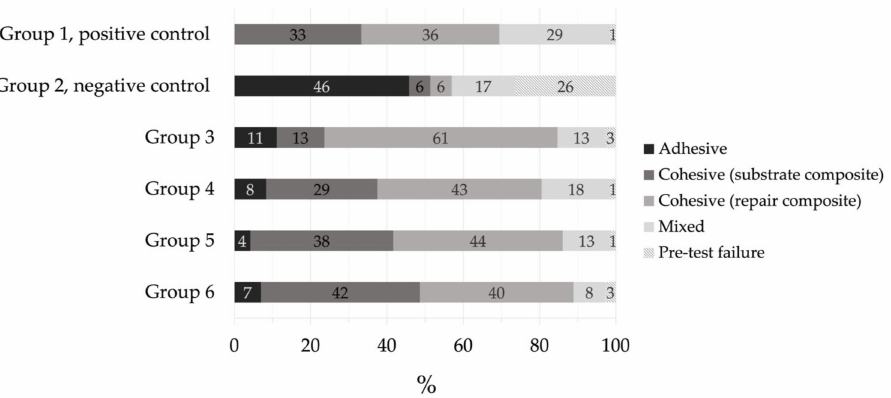
Figure 3. Percentage (%) of failure mode distribution per